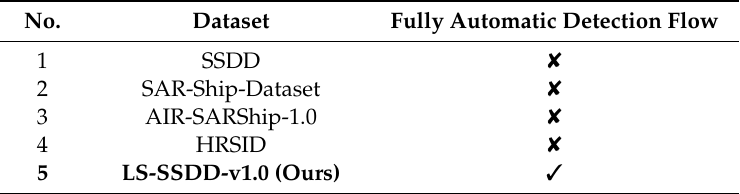
Table 7. Fully automatic detection flow comparison.